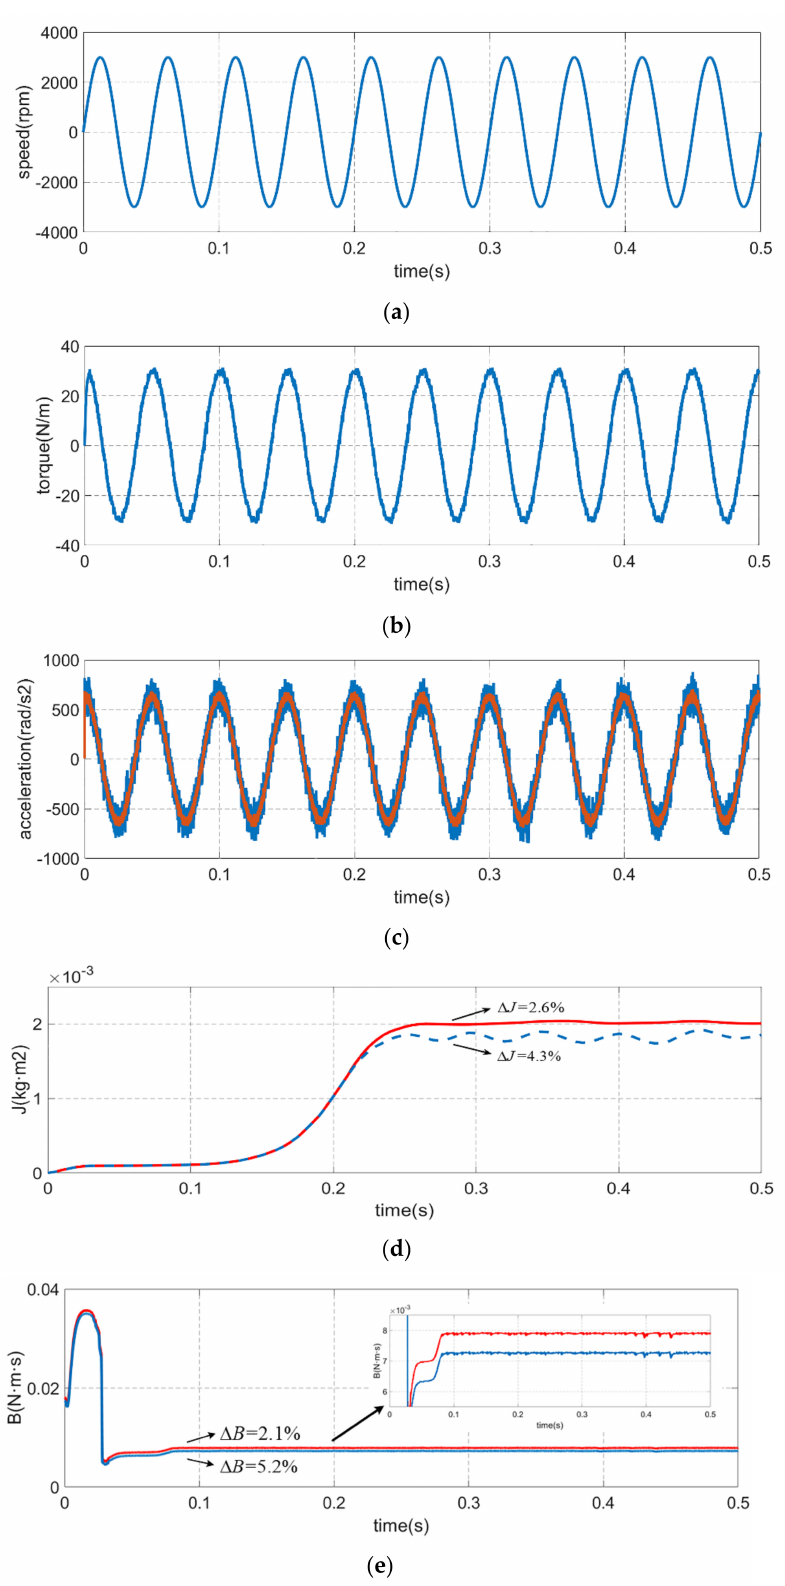
Figure 8. Comparison of inertia and friction coefficient identification results at the sinusoidal reference speed of 20 Hz, 3000 r/min which the blue line represents the classical integration method and red line represents the improved integration method. ( a ) motor speed. ( b ) electrical torque. ( c ) acceleration. ( d ) moment of inertia. ( e ) viscous friction